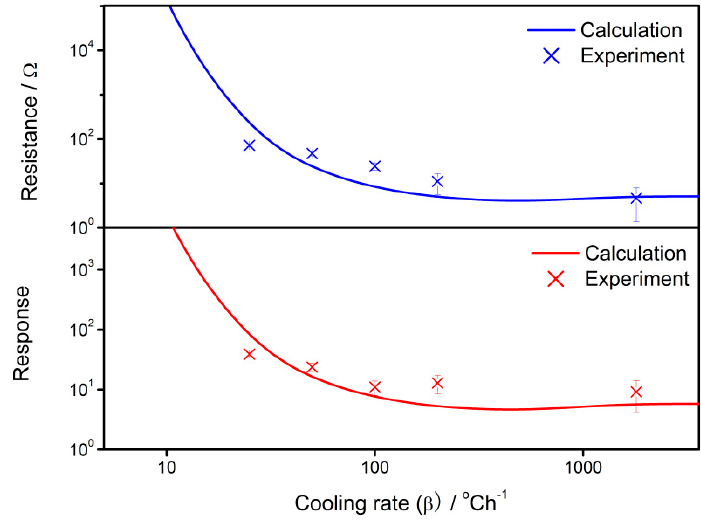
Figure 11. Calculation and experimental results of the sensor properties against the cooling rate of 25–1800 °C/h.